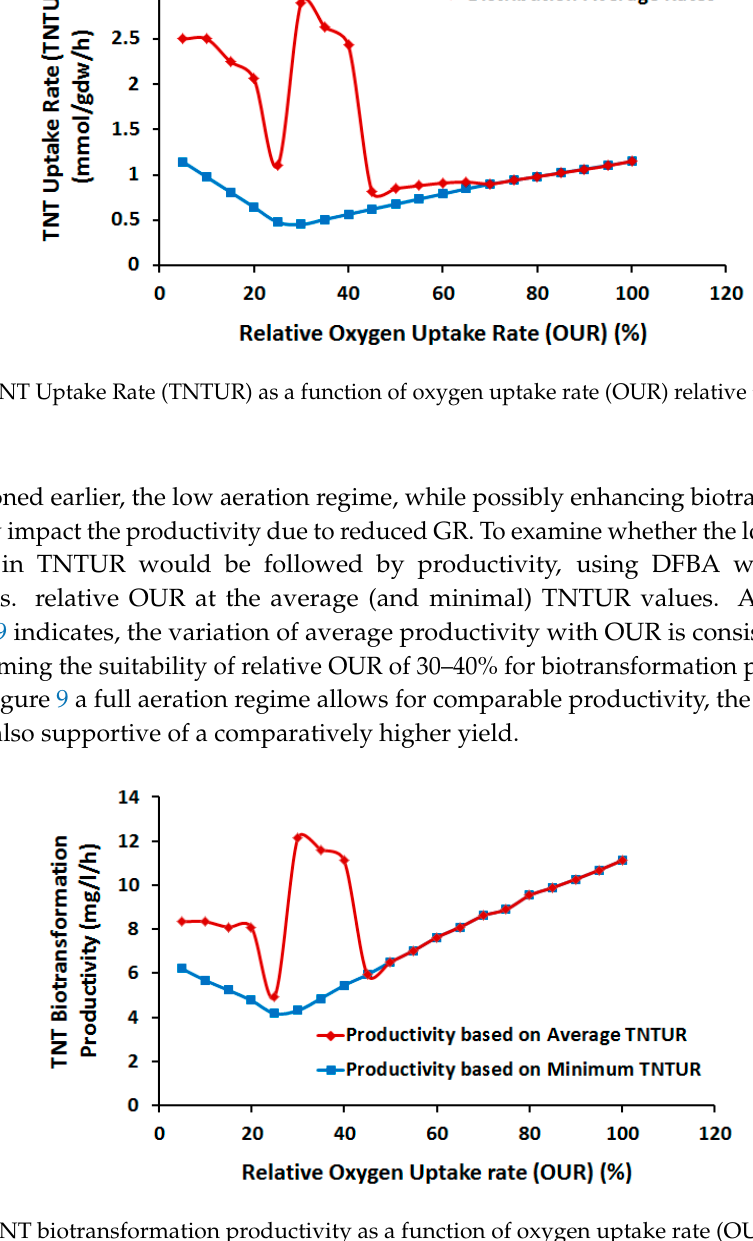
Figure 9. TNT biotransformation productivity as a function of oxygen uptake rate (OUR) relative to the optimal value (%).